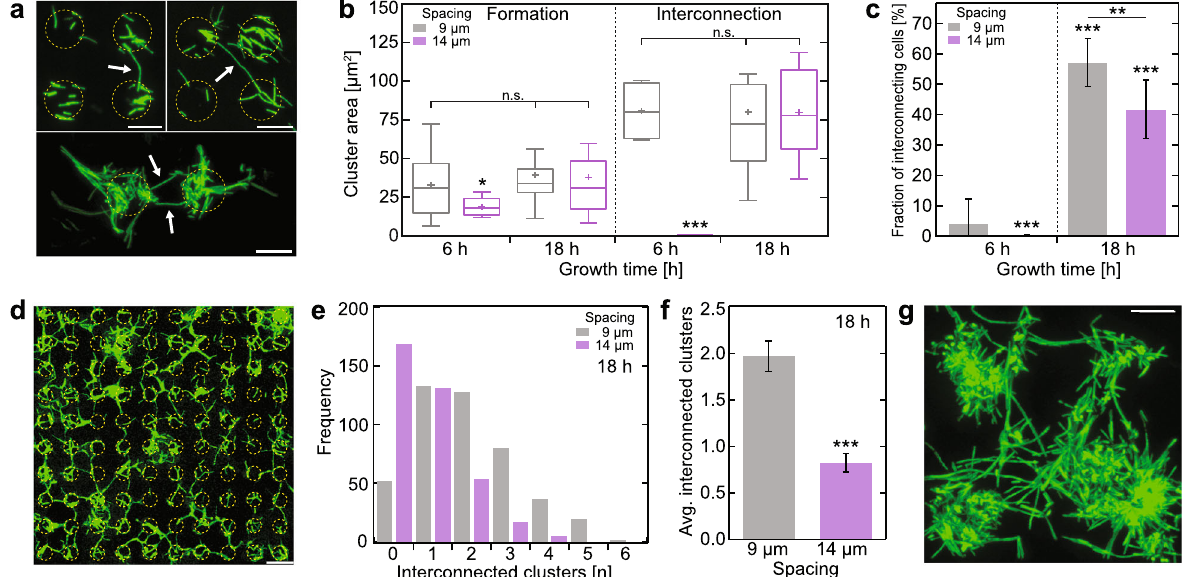
Fig. 4 Filamentous cell growth is directed to adjacent bacterial clusters and interconnect cell clusters to a large network. a Example fl uorescence images of bacterial cluster pairs interconnected by fi lamentous cells, indicated by arrows; scale bar depicts 10 µm. b Bacterial cluster area-dependent formation of fi lamentous cells and fi lamentous cells that interconnect adjacent clusters for 9 and 14 µm spacing, grown for 6 and 18 h. Cluster size is normalized to the number of fi lamentous cells. Legend for box and whisker plot: the centerline denotes the median value (50th percentile), the cross the mean average, the bounds of the box contain the 25th-75th percentiles, the whiskers mark the 1.5 interquartile range. c Fractions (mean ± s.d.) of interconnecting cells of all fi lamentous cells observed for 9 and 14 µm distances, grown for 6 and 18 h. d Example fl uorescence image of an Au disk array with 9 µm spacing after 18 h growth shows multiple interconnected bacterial clusters; scale bar depicts 20 µm. e Degree of interconnected clusters ( N = 446 for 9 µm, N = 372 for 14 µm distances) and f average number (mean ± 95% con fi dence interval) of cluster interconnections of 9 and 14 µm distances arrays after 18 h growth. g In-vitro CLSM fl uorescence image of growing bio fi lm, originating from clusters interconnected with multiple fi lamentous cells; scale bar depicts 20 µm. Asterisks indicate statistical signi fi cance (* p < 0.05; ** p < 0.01; *** p < 0.001; n.s. = non-signi fi cant), resulting from two-tailed, unpaired t -tests. See also Supplementary Fig.